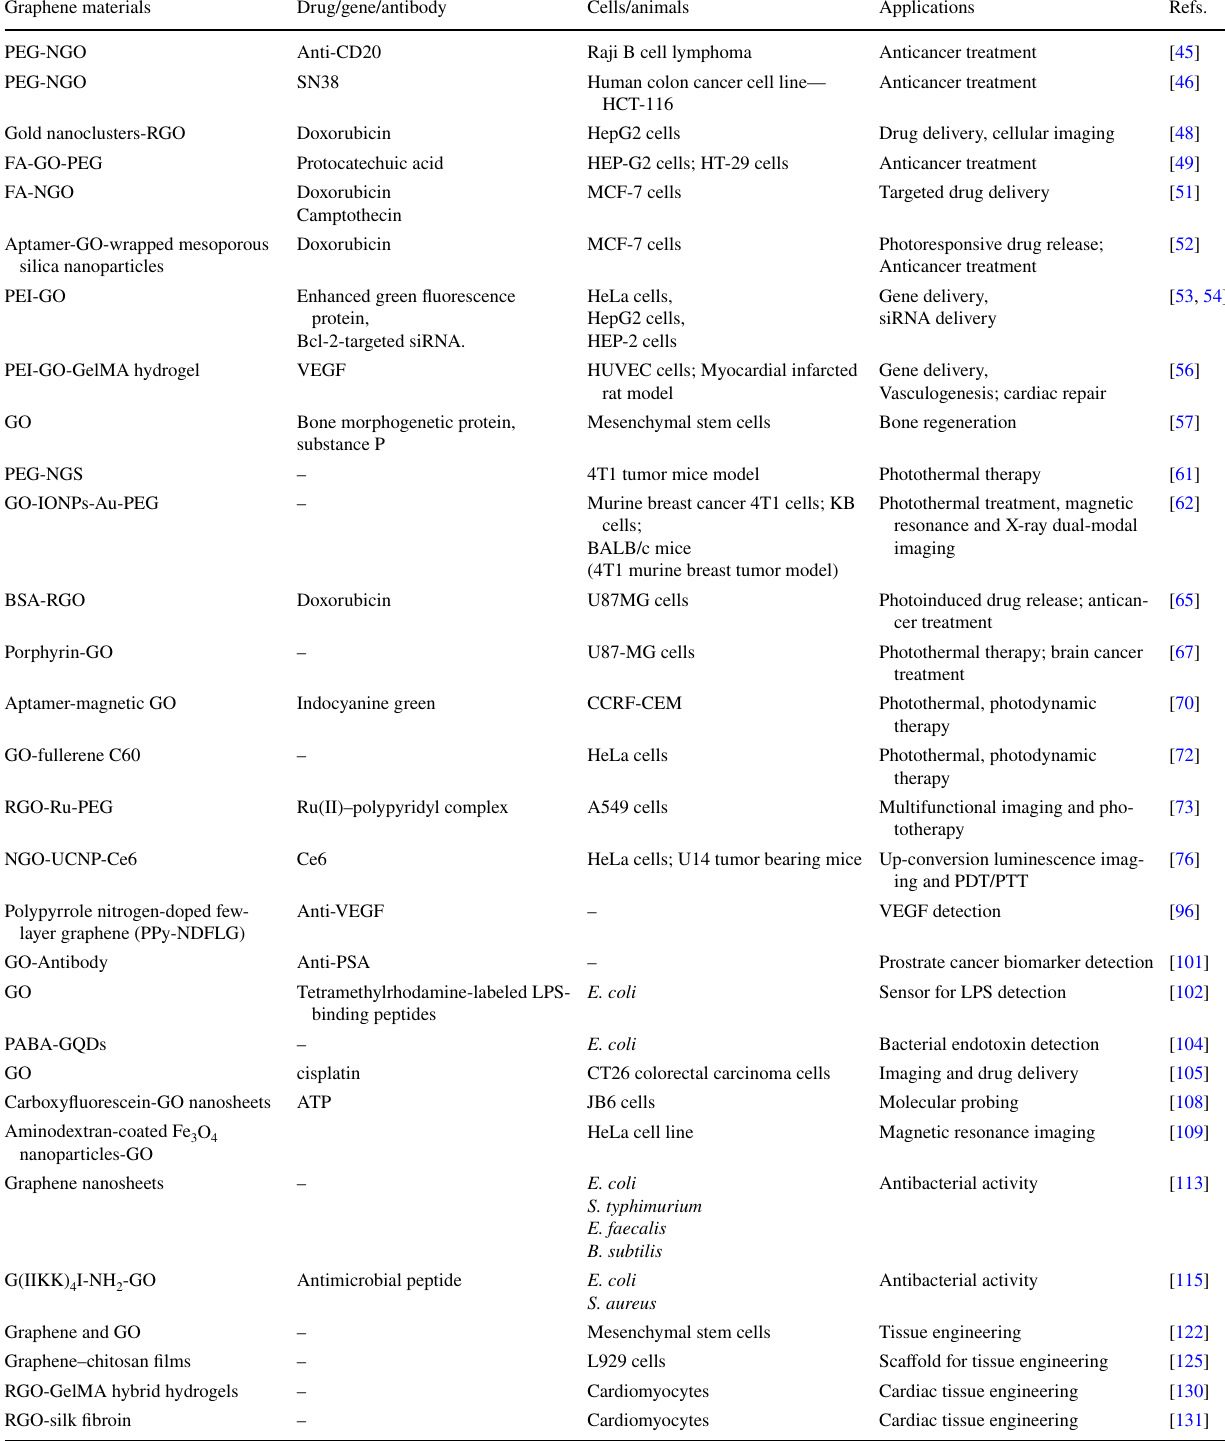
Table 2 Biomedical applications of the graphene family materials Graphene